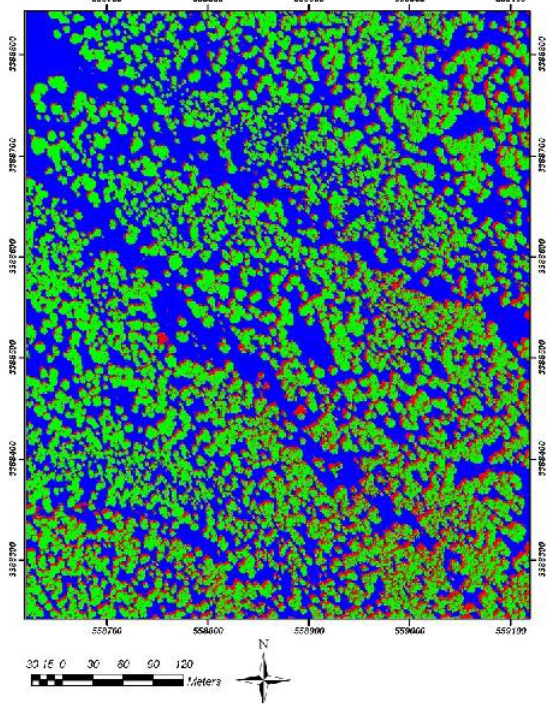
Figure 4: The best classification results of the VHR imagery by